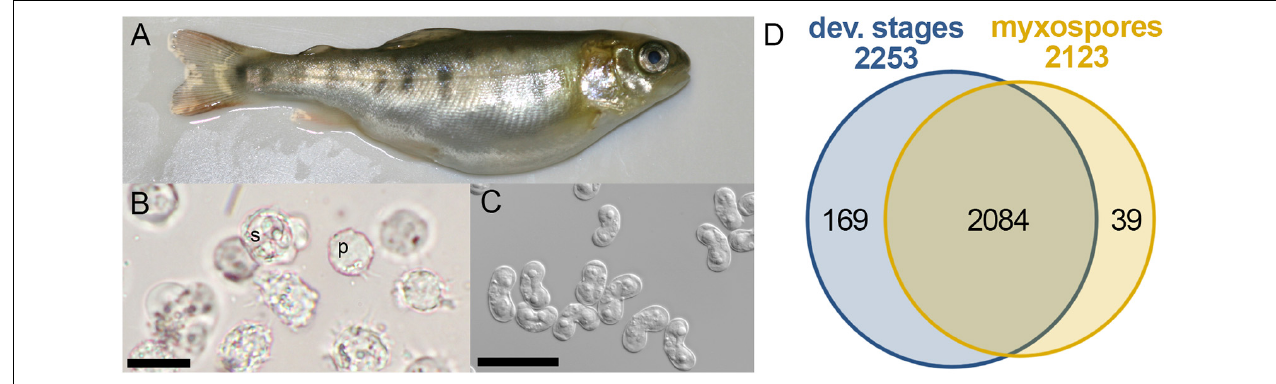
FIGURE 1 | Comparative proteomics of Ceratonova shasta stages from fish. (A) Infected fish showing bloated abdomen typical of ascites production. (B) Developmental stages extracted from ascites: pre-sporogonic, p; sporogonic, s; bar 20 µ m. (C) Purified mature myxospores; bar 20 µ m. (D) Venn diagram of identified protein groups in developmental stages and mature